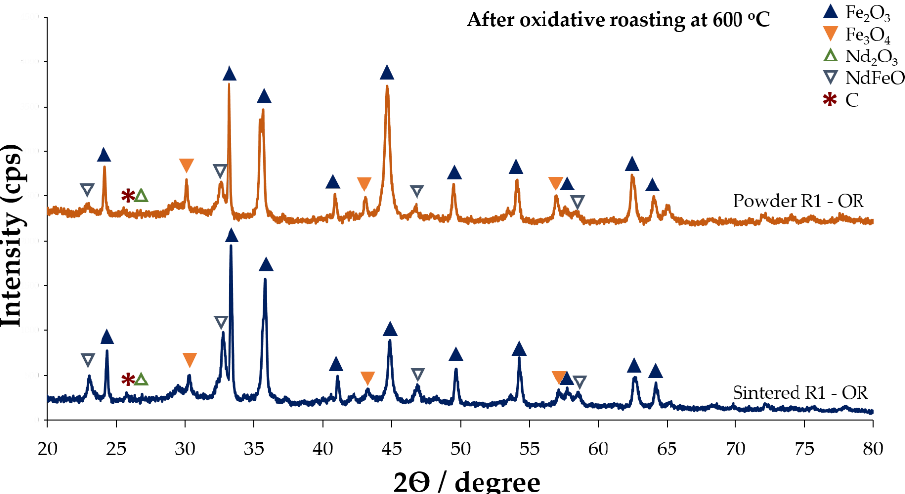
Figure 5. An XRD analysis after oxidative roasting of NdFeB waste in sintered and powder forms.